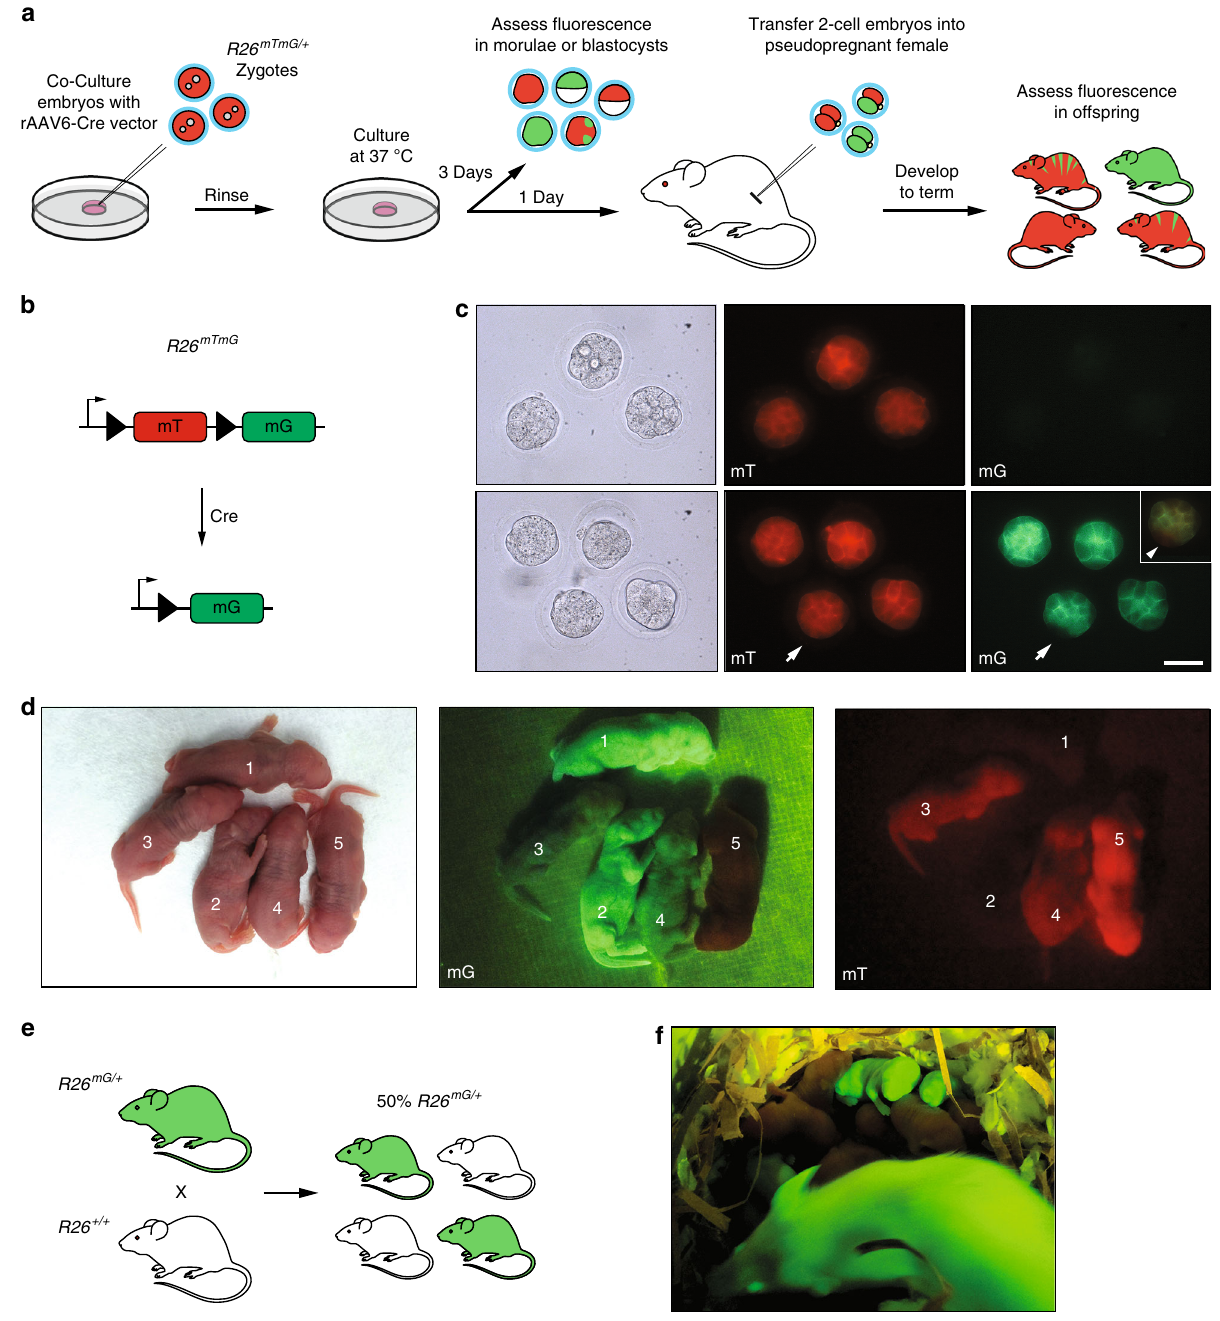
Fig. 1 Recombinant AAV vectors can induce Cre-LoxP recombination. a Schematic representation of the strategy to induce Cre-LoxP recombination using rAAVs. R26 mTmG heterozygous zygotes derived from breeding R26 mTmG homozygous and wild-type mice were placed in a drop of KSOM media containing rAAV particles, rinsed, cultured in KSOM, and analyzed for fl uorescence after 3 days in culture or were transferred into pseudopregnant females after 1 day in culture and allowed to develop to term. b Schematic representation of the R26 mTmG fl uorescence reporter. R26 mTmG embryos express the membrane- targeted tdTomato gene ( mT ) and fl uoresce red. Cre-mediated recombination drives expression of membrane-targeted EGFP ( mG ), making recombined cells fl uoresce green. c Fluorescence analysis of compacted morulae transduced with rAAV6- Cre . Maternal mT protein is present in both non-treated (top row) and treated (bottom row) embryos, making them fl uoresce red. Transduction with rAAV6- Cre leads to green fl uorescent embryos (bottom row), indicative of Cre-mediated recombination. Inset is a merged image of the embryo marked by arrows to highlight mosaicism evident by the absence of green fl uorescence in some cells. Scale bar equals 50 μ m. d Fluorescence analysis of pups derived from zygotes transduced with rAAV6- Cre in culture and transferred into pseudopregnant females. Two pups show complete Cre-lox recombination (1 and 2), two are mosaic (3 and 4), and one (5) did not undergo recombination. e Schematic representation of the strategy to test for germline transmission of the recombined R26 mG allele obtained after rAAV6- Cre treatment of R26 mTmG/ + zygotes in culture. f R26 mG/ + mother and her offspring derived from a cross to a wild-type male; two R26 mG/ + pups are